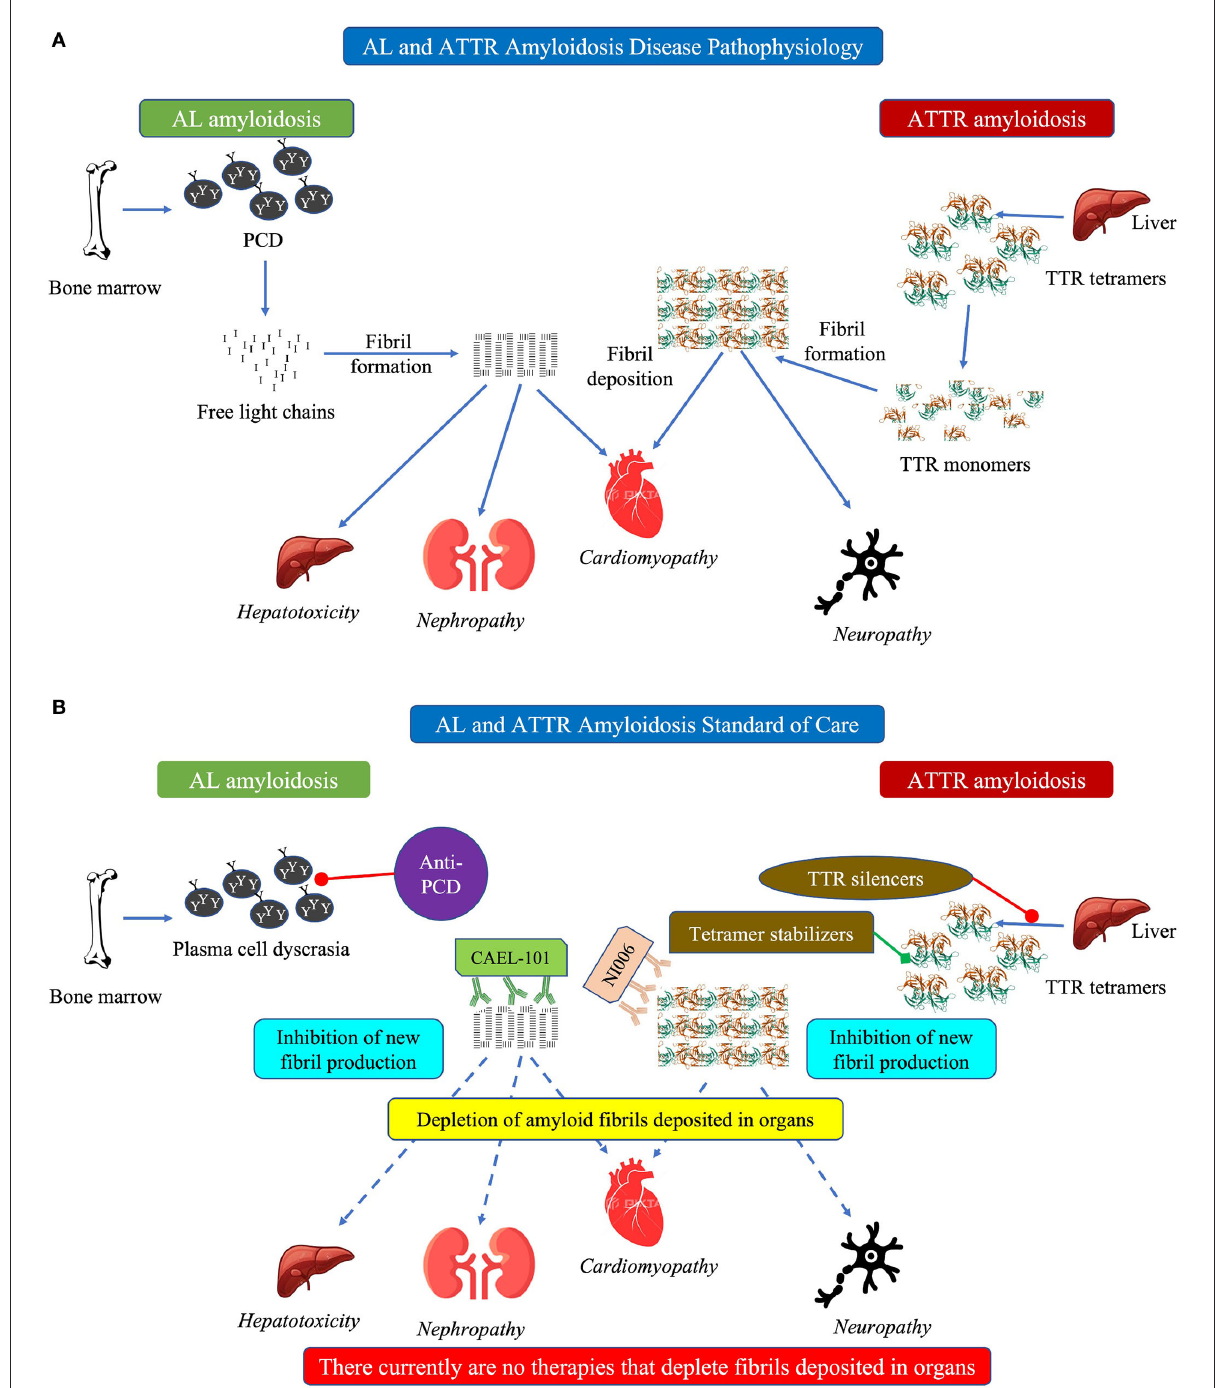
FIGURE1 (A) Schematic diagram showing pathophysiology of cardiac amyloidosis and (B) schematic diagram showing current standard of care in cardiac amyloidosis. In (A) this schematic figure shows the pathophysiology of how both AL (left side) and ATTR (right side) amyloidosis can cause cardiomyopathy. In (B) this schematic figure shows the current standard of care for AL amyloidosis (anti-PCD) and ATTR amyloidosis (TTR silencers, tetramer stabilizers). Text in italics indicate manifestations of the disease. AL, light chain amyloidosis; ATTR, transthyretin amyloidosis; PCD, plasma cell dyscrasia; TTR,